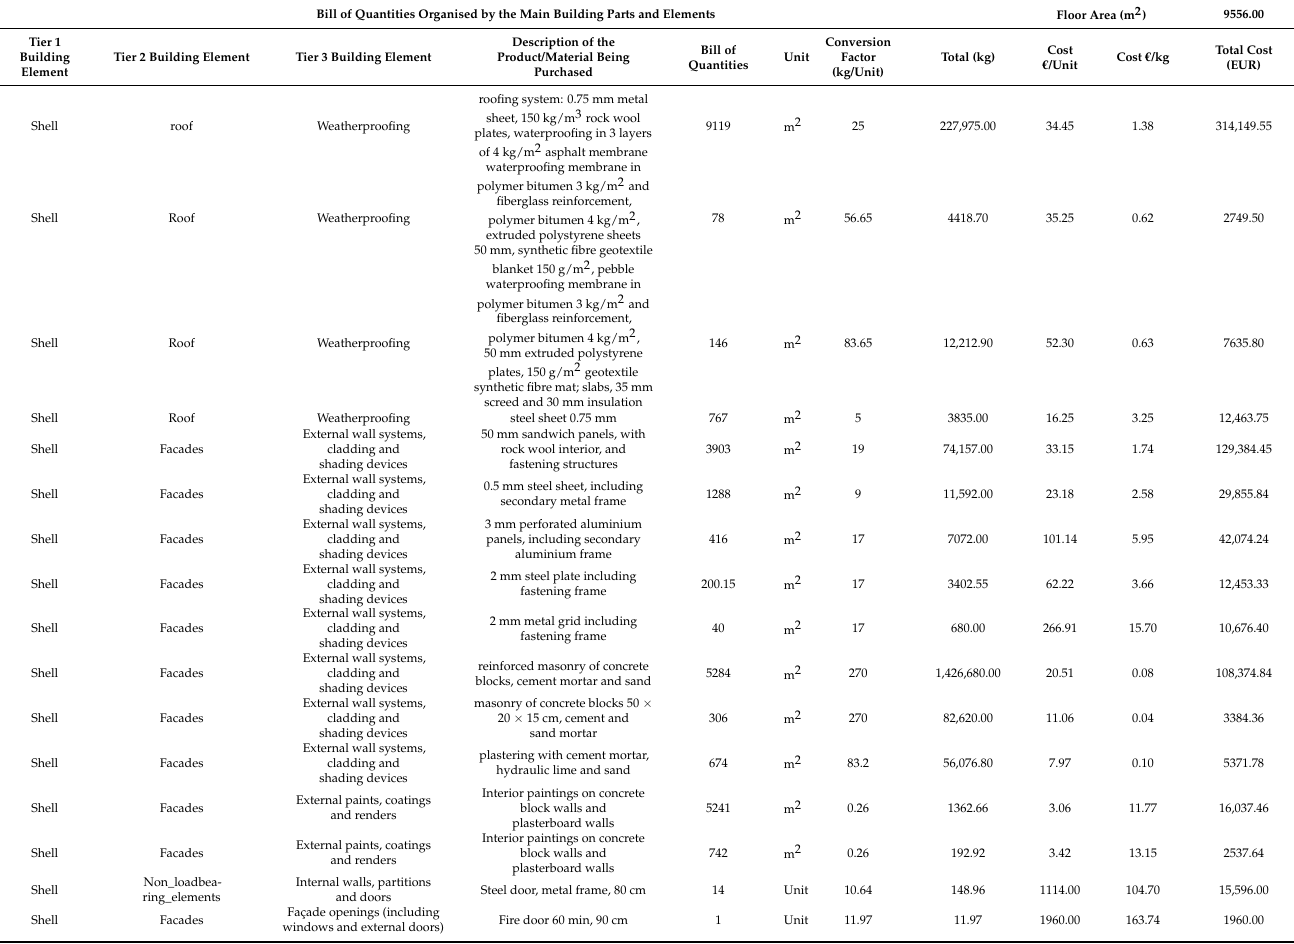
Table A1. Bill of quantities input of shell building elements for the analysed retail store, according to level(s) template